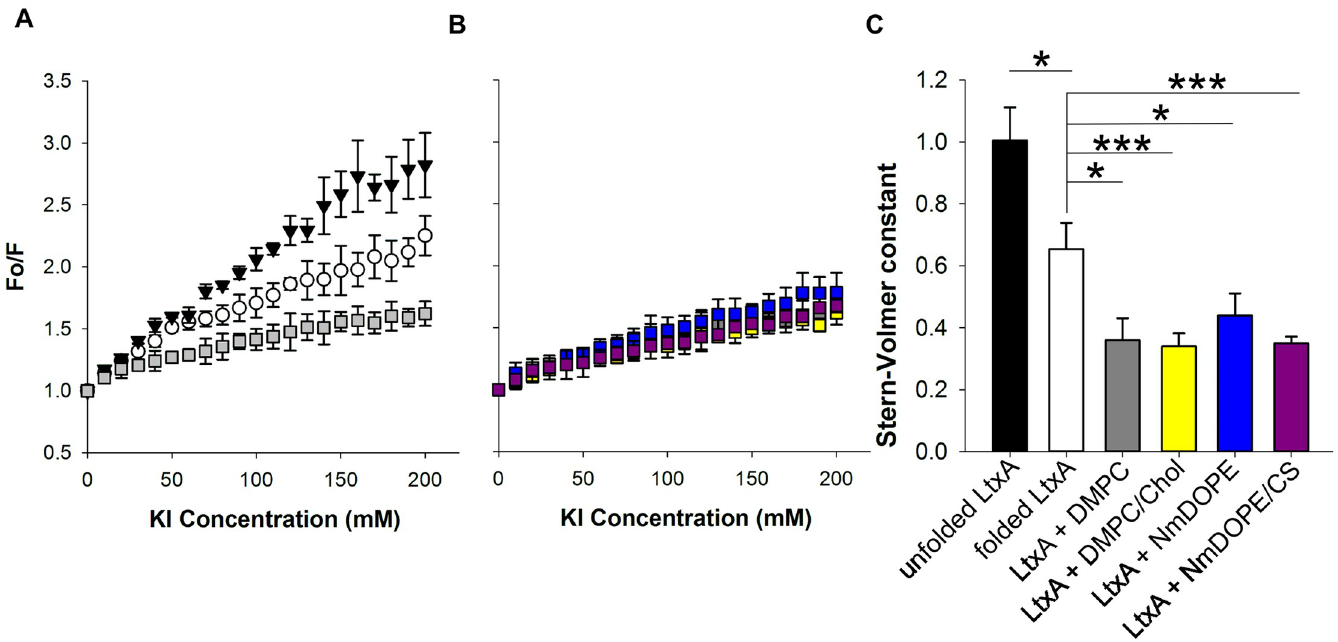
Fig 3. Tryptophan quenching of LtxA by KI. (A) Stern-Volmer plots, showing solvent accessibility of unfolded LtxA (black triangles), LtxA in solution (white circles), and LtxA incubated with DMPC (grey squares). The slopes of each line represent the Stern-Volmer constant (K SV ), a measure of solvent accessibility of the five Trp residues within LtxA. (B) Stern-Volmer plots of LtxA in different membrane environments: DMPC (grey), DMPC + 40% Chol (yellow), NmDOPE (blue), and NmDOPE + 25% CS (purple). (C) Stern-Volmer constants (K SV ) of the data shown in panels (A) and (B). In unfolded LtxA, K SV is 1.0. In this unfolded state, 100% of the Trp residues are exposed to quencher; therefore, this value corresponds to 100% accessibility of the Trp residues. When LtxA is folded, K SV decreases to 0.6, corresponding to 60% accessibility of the residues. When LtxA is incubated with membranes, regardless of the lipid composition, K SV decreases to 0.4, indicating 40% accessibility of the residues. � , p < 0.05; ��� , p <